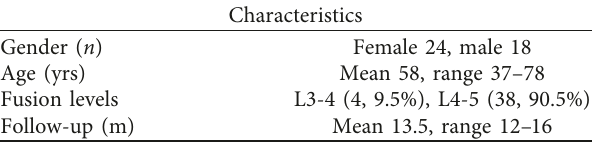
Table 1: Main basic demographics and diagnosis of patients.